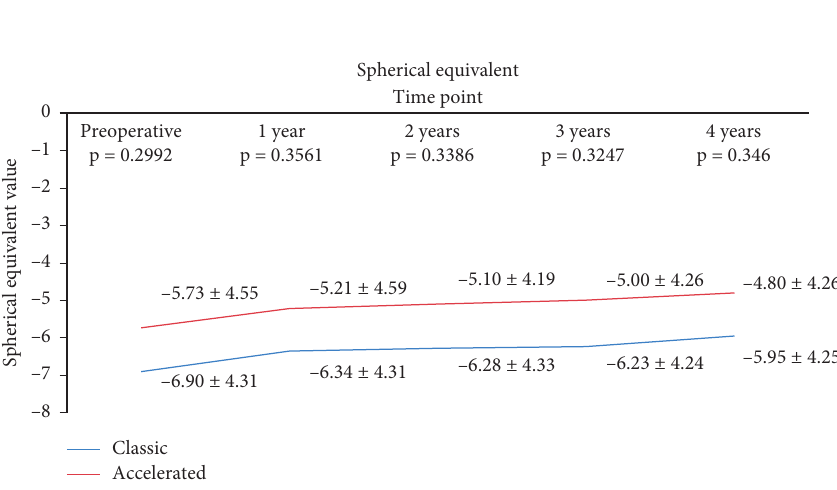
Figure 5: Evolution of cylinder in both groups.